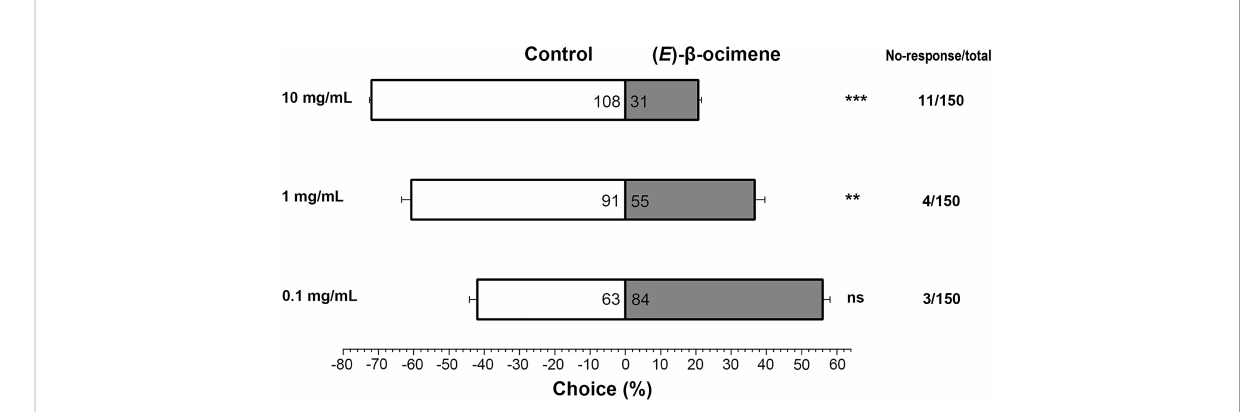
FIGURE 6 Behavioral preference of Spodoptera litura larvae for ( E )- b -ocimene. Data were tested for signi fi cant differences using a c 2 test **P < 0.01; ***P < 0.001; ns, no signi fi